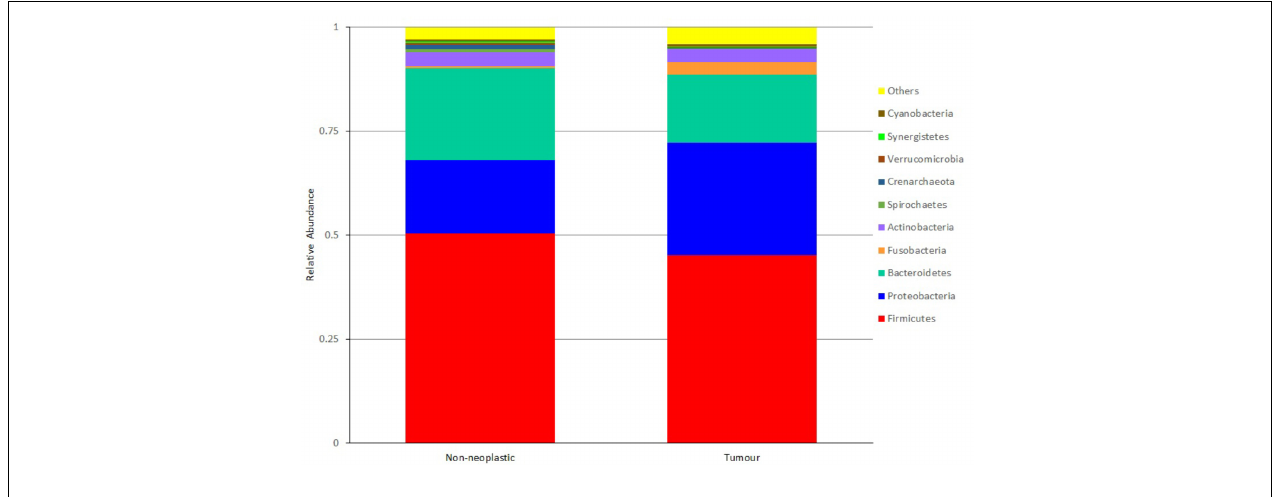
FIGURE 4 | Microbiota structures in the non-neoplastic mucosae and tumours at phylum level.